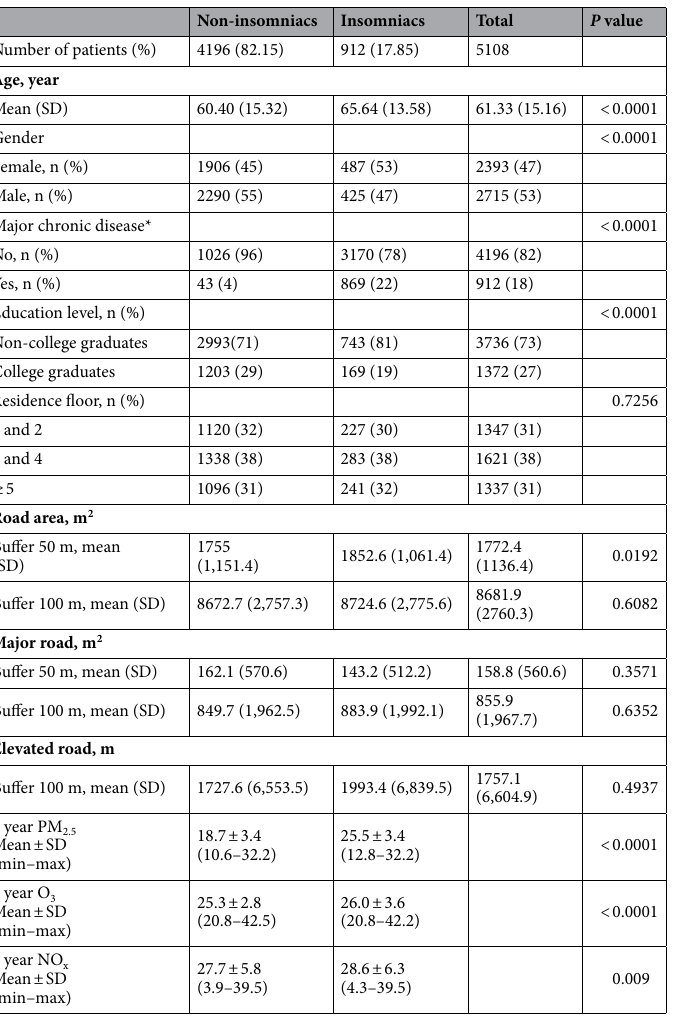
Table 1. Comparison of age, gender, major chronic diseases, educational level, residence floor, road area, major road, elevated road and distribution of exposure concentrations of PM 2.5 (unit: µg/m 3 ), ozone (unit: ppb), and NO x (unit: ppb) at 1 year before the date of insomnia diagnosis for insomniacs or last date of outpatient visit for non-insomniacs based on monitoring stations between non-insomniacs and insomniacs of 5108 outpatients in Taipei City Hospital. *Chronic diseases include psychiatric disease, coronary heart disease, congestive heart failure, cerebrovascular disease, dementia, pulmonary disease, peptic ulcer disease and reflux esophagitis, chronic hepatic disease, diabetes, chronic kidney disease, and